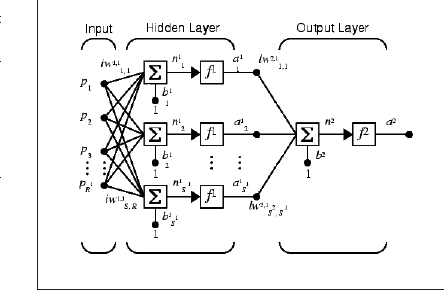
Fig. 16.1. Architecture of the Neural Network